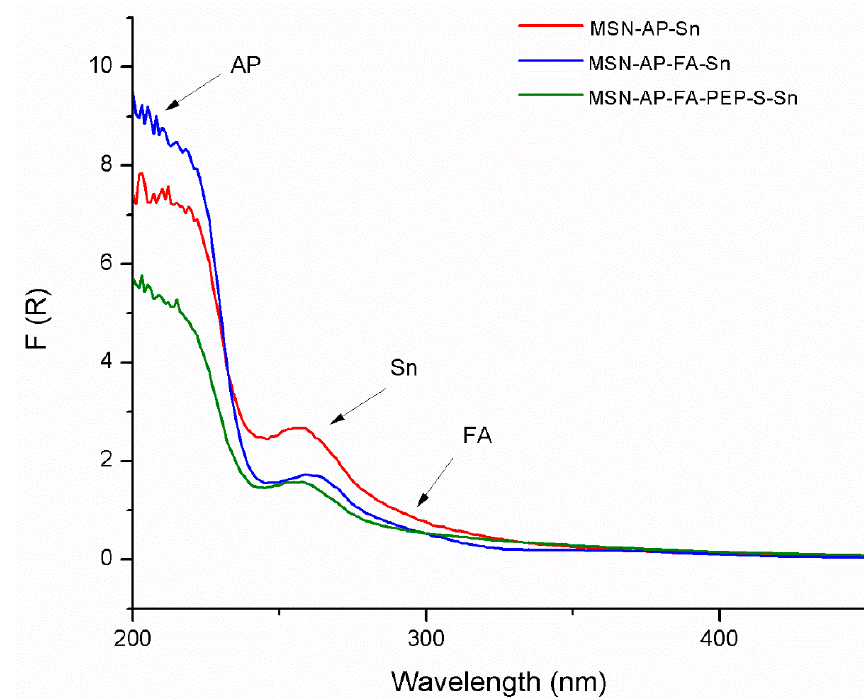
Figure 1. Diffuse reflectance ultraviolet spectroscopy (DR-UV) spectra of the tin-functionalized materials MSN-AP-Sn, MSN-AP-FA-Sn, and MSN-AP-FA-PEP-S-Sn. MSN-AP-Sn, MSN-AP-FA-Sn, and